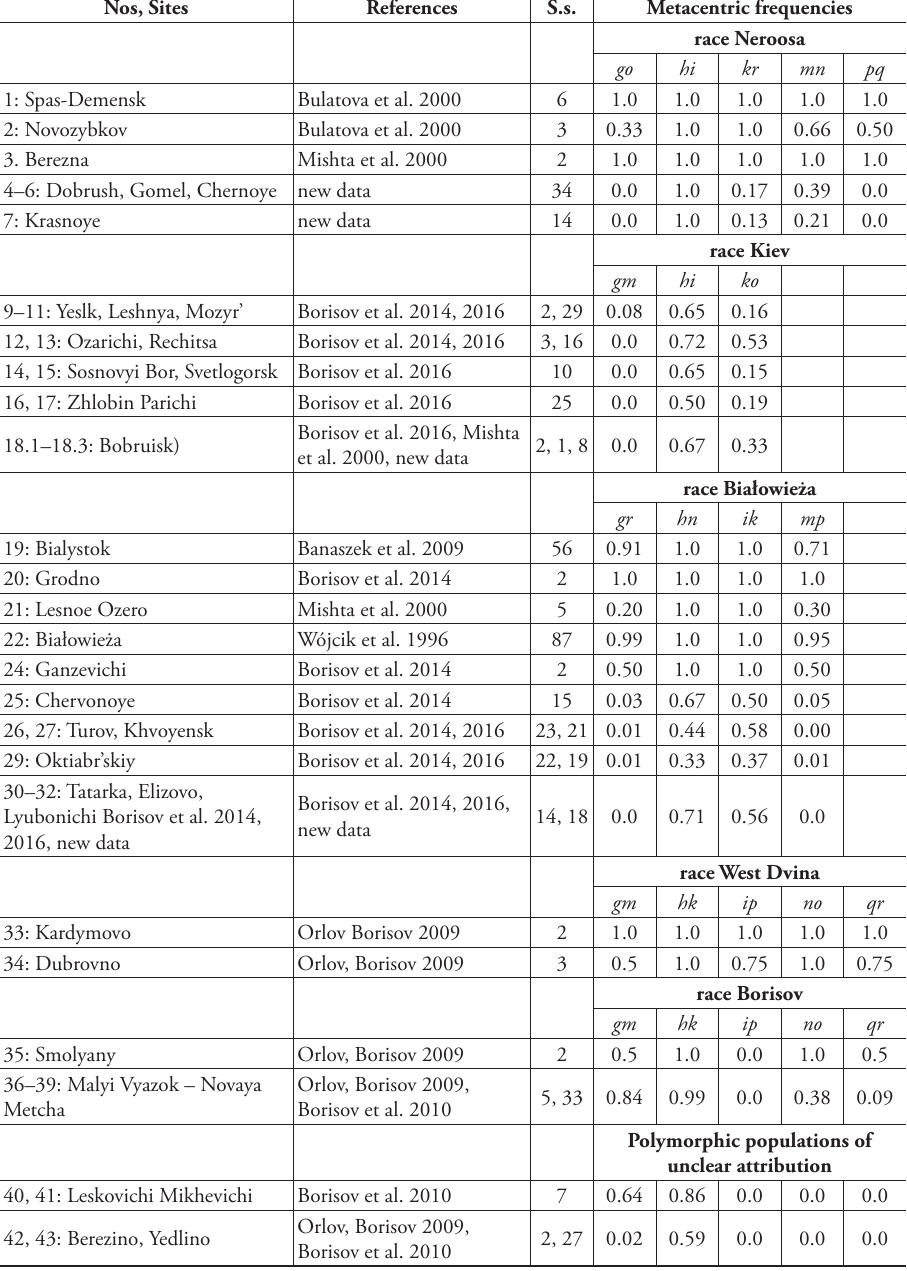
Table 2. Frequencies of race-specific metacentrics in populations of eight chromosome races of S. ara- neus . Numbers of sites are the same as in Table 1 and in Fig. 1; the frequency of Rb translocations is an average of studied specimens from all samples. S.s., sample size; two-three digits in column “S.s”. are ar- ranged in the same order as references in column